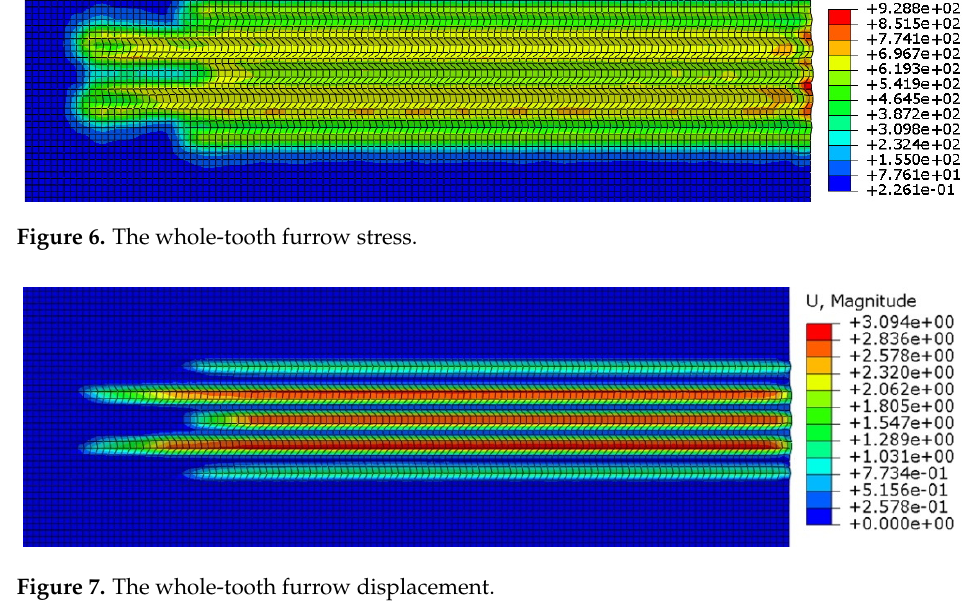
Figure 6. The whole-tooth furrow stress.